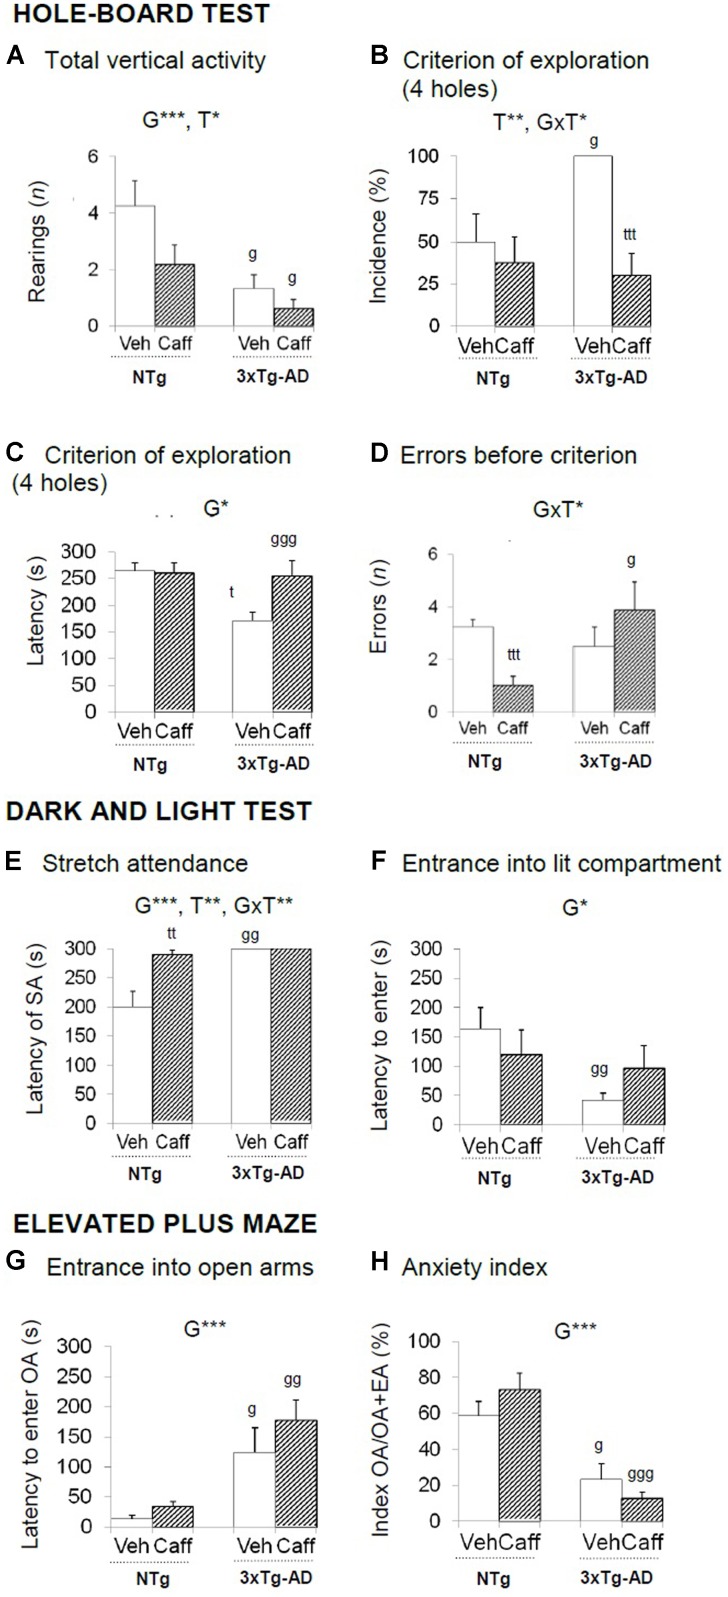
Effects of chronic caffeine treatment assessed in the HB, DLB, and EPM tests in NTg and 3xTg-AD mice at 13 months of age. Data are expressed as mean ± SEM. (A–H) Behavioral variables (as indicated) of the hole-board test (A–D), the dark and light test (E,F) and the elevated plus maze (D–H). The text at the top of each graph refers to the p-values of the 2 × 2 ANOVA: G, genotype effect; T, treatment effect; GxT, genotype × treatment interaction; ∗p < 0.05, ∗∗p < 0.01, ∗∗∗p < 0.001. Post hoc comparisons are shown in the graphs as: g p < 0.05, gg p < 0.01 vs. the corresponding NTg group; ∗p < 0.05, ∗∗p < 0.01, ∗∗∗p < 0.001 vs. the corresponding non-treated group. SA, stretch attendance.